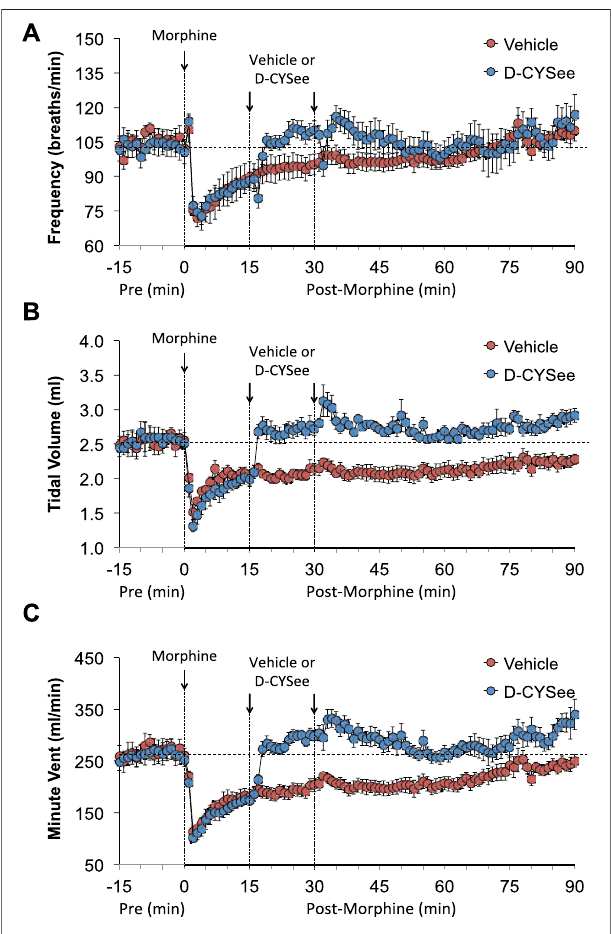
FIGURE 1 | Values of frequency of breathing (Panel (A) ), tidal volume (Panel (B) ),andminuteventilation(Panel (C) )infreely-movingratspriorto(pre) and following injection of morphine (10 mg/kg, IV) and subsequent injections of vehicle (saline, IV) or D-cysteine ethyl ester (D-CYSee, 500 μ mol/kg, IV).Dataarepresentedasmean±SEM.Therewere5ratsinthevehicle group and 6 rats in the D-CYSee group.